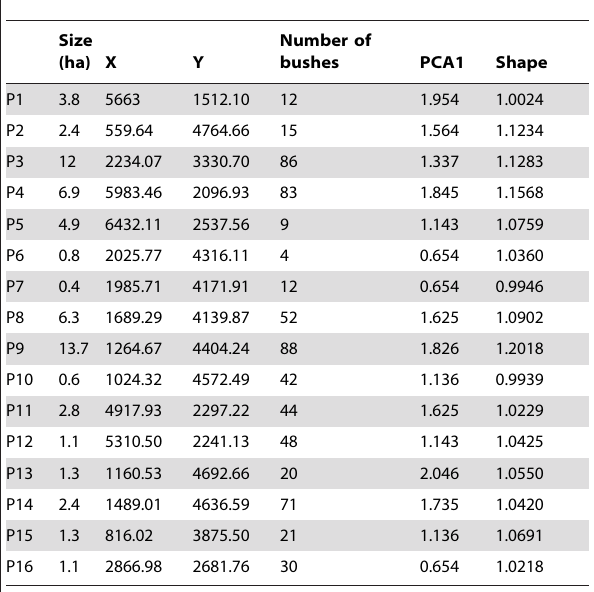
PCA1= site scores obtained by PCA ordination over a matrix of land-use types surrounding the fragments. Variance explained by axis 1=73%.